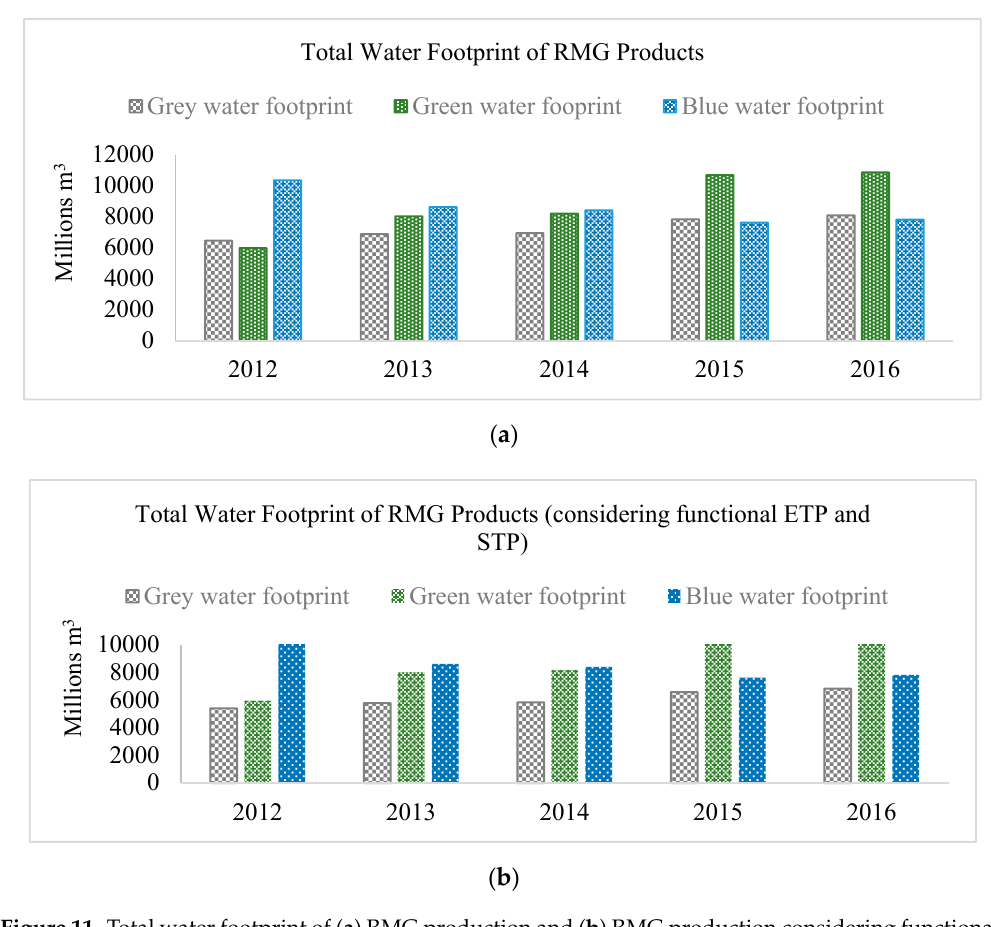
Figure 11. Total water footprint of ( a ) RMG production and ( b ) RMG production considering functional Effluent Treatment Plant (ETP) and Sewerage Treatment Plant (STP).